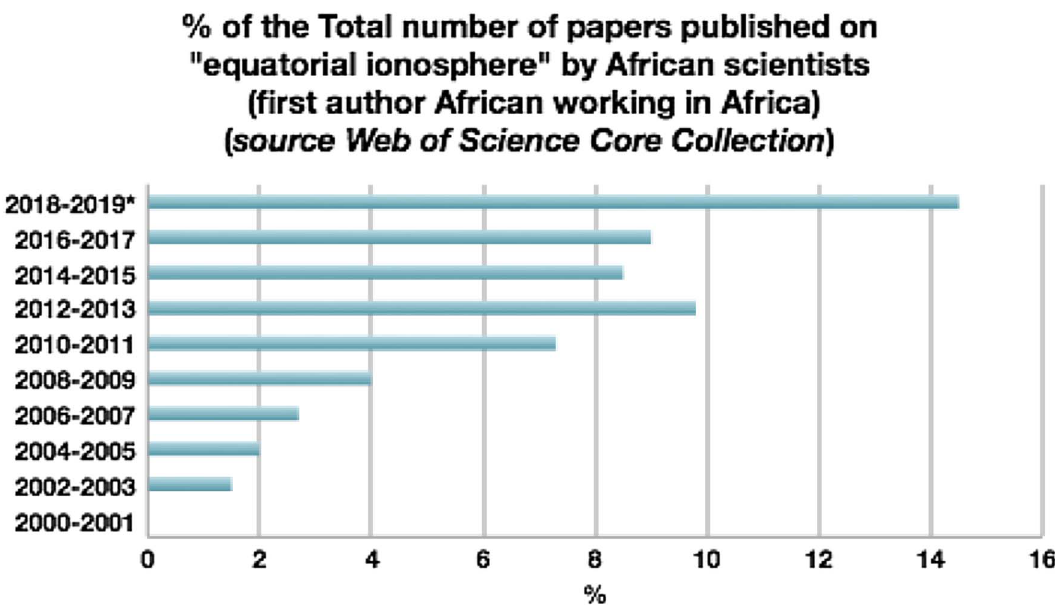
Fig. 3. Percentage of papers published by African scientists from Web of Science Core